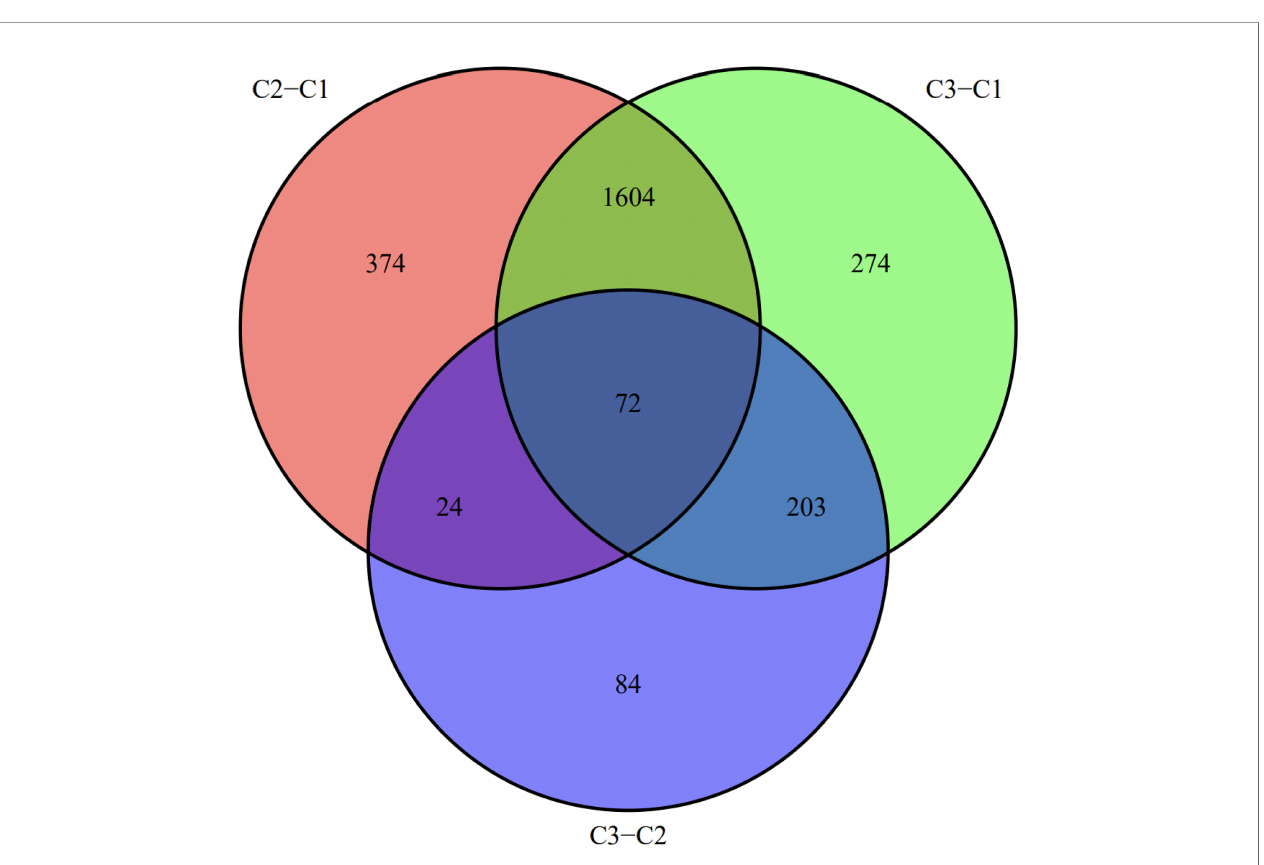
FIGURE 5 | Venn diagram, a common set of differential genes for the three cancer